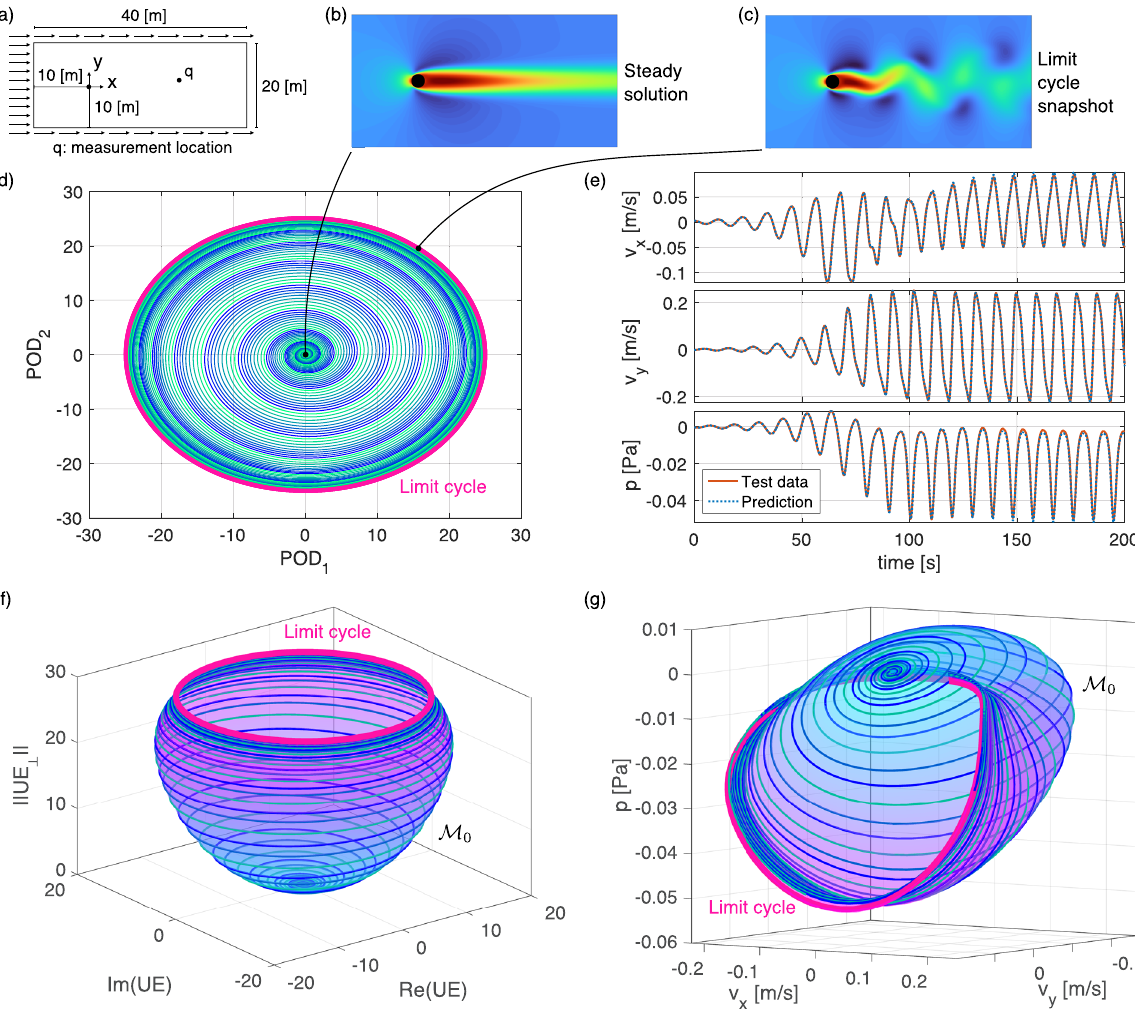
Fig. 5 Data-driven nonlinear SSM-reduced model on the unstable manifold of the steady solution of the fl ow past a cylinder. a Problem setup. b , c Snapshots of the steady solution and the time-periodic vortex-shedding solution (limit cycle, in magenta). d Trajectories projected on the 2-dim. subspace spanned by the two-leading POD modes of the limit cycle. e Model-based reconstruction of the test trajectory (not used in learning the SSM) in terms of velocities and pressures measured at a location q shown in plot a . f The SSM formed by the unstable manifold of the origin, along with some reduced trajectories, plotted over the unstable eigenspace UE ≡ E 1 ; ∥ UE ⊥ ∥ denotes the normed projection onto the orthogonal complement UE ⊥ . g Same but projected over velocity and pressure